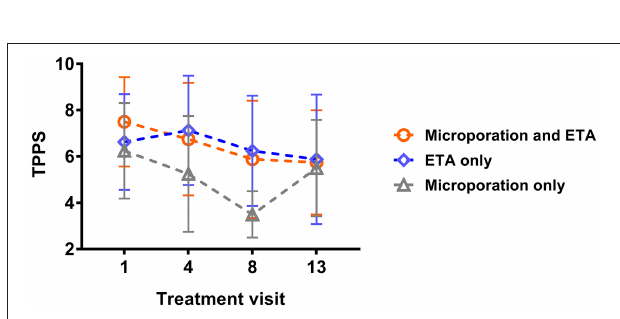
FIGURE 2 | Individual TPSS values at visit 1 and visit 13 for the respective treatment areas. TPSS for etanercept ( n = 8), etanecept + Er:YAG laser microporation ( n = 8) and Er:YAG laser microporation ( n = 4).